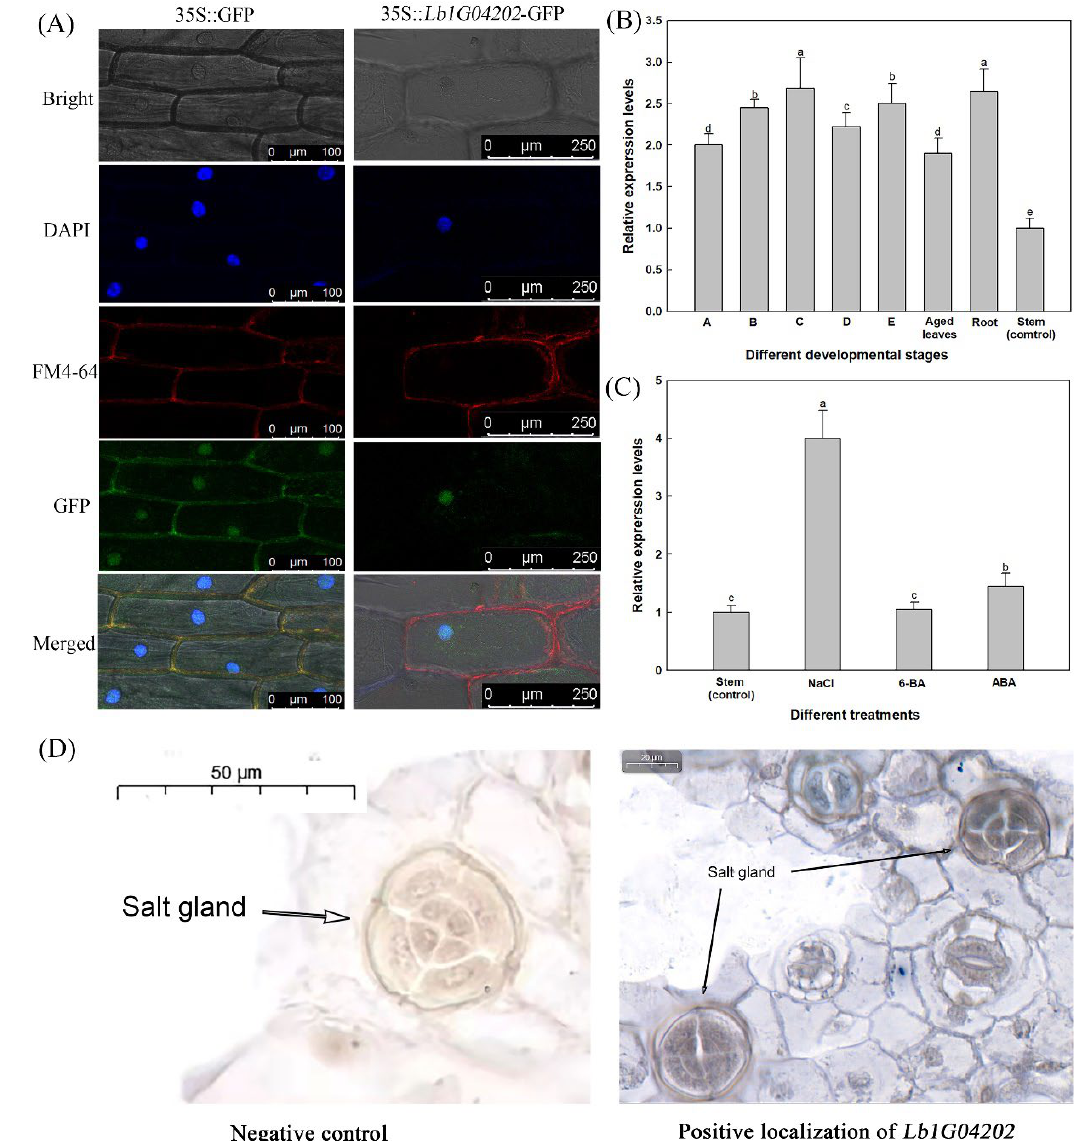
Figure 2. Localization and expression level analysis of Lb1G04202 . ( A ) Subcellular localization analysis of 35S:: Lb1G04202 -GFP in onion epidermal cells. The GFP-Lb1G04202 fusion protein was expressed in the nucleus only. 35S::GFP was used as the empty vector control. Bar = 50 µ m. DAPI appears as blue fluorescence specifically in the nucleus and FM4-64 appears as red fluorescence at the plasma membrane. ( B ) Lb1G04202 expression levels in Limonium bicolor at developmental stages (A–E) and in different tissue parts. A: undifferentiated stage, 4–5 d after sowing; B: salt gland differentiation stage, 6–7 d after sowing; C: stomatal differentiation stage, 8–10 d after sowing; D: epidermal differentiation stage, 11–16 d after sowing; E: mature stage, more than 17 d after sowing; Aged leaves: fully expanded leaves. Roots and stems were collected from mature plants. Data are the means ± SD of three replicates. Different letters indicate significant differences at p = 0.05 according to Duncan’s multiple range test. ( C ) Lb1G04202 expression levels in L. bicolor under different treatments. NaCl: mature leaves from stage E seedlings after 24 h of 200 mM NaCl treatment; 6-BA: mature leaves from stage E seedlings grown on 0.04 mg/L 6-BA; ABA: mature leaves from stage E seedlings grown on 0.1 mg/L ABA. ( D ) In situ hybridization of Lb1G04202 using stage B–D leaves from L. bicolor . Negative control: the probe did not connect any nucleic acid sequence and could not detect any transcripts. Positive localization of Lb1G04202 : Lb1G04202 transcripts were detected using a digoxin-labeled anti-sense probe, which produces a blue-violet color.